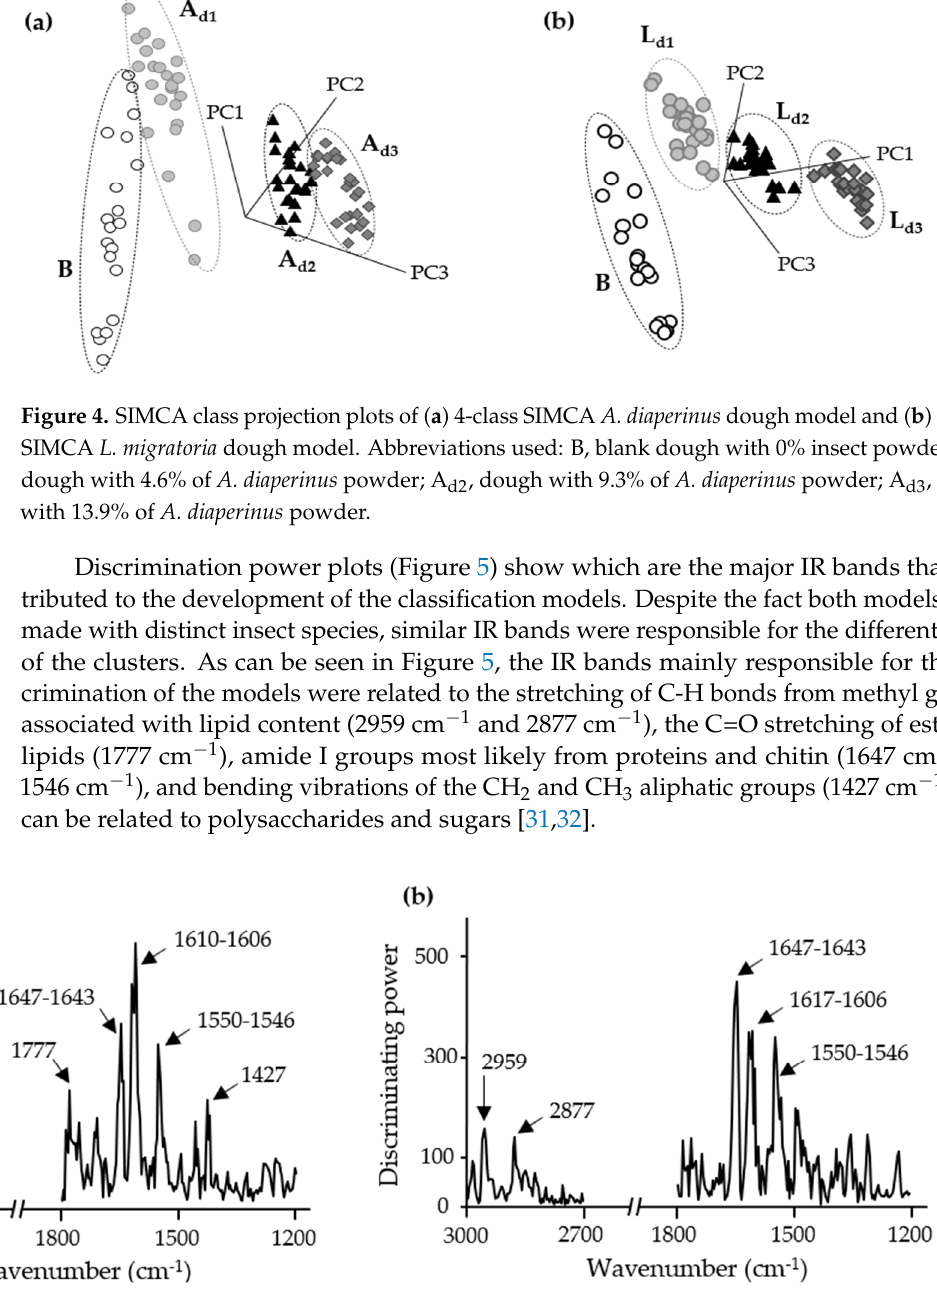
Figure 5. Soft independent modeling of class analogy discriminating power plots of FTIR spectroscopy spectra (3000–2700 cm − 1 and 1800–1200 cm − 1 ) from ( a ) 4-class SIMCA A. diaperinus dough model and ( b ) 4-class SIMCA L. migratoria dough model.